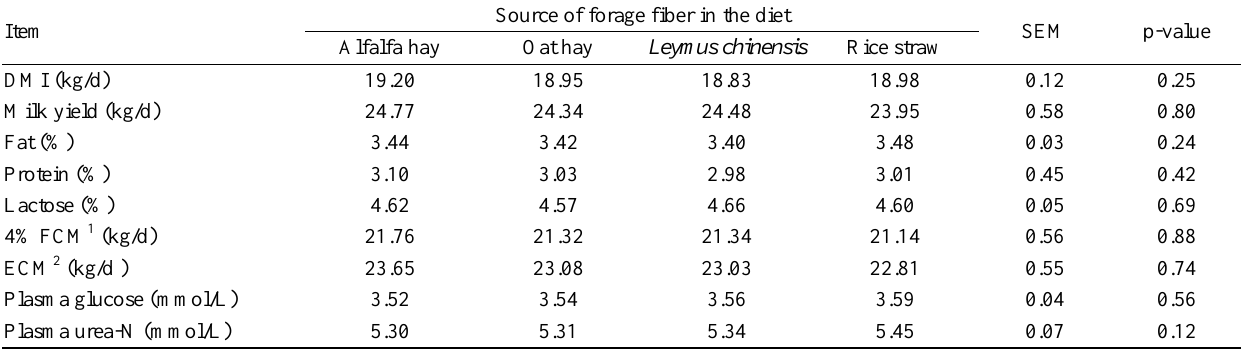
Table 2. Effects of alfalfa hay, oat hay, Leymus chinensis , and rice straw as dietary forage sources on the DMI, milk production, and plasma metabolites of dariy cows Item